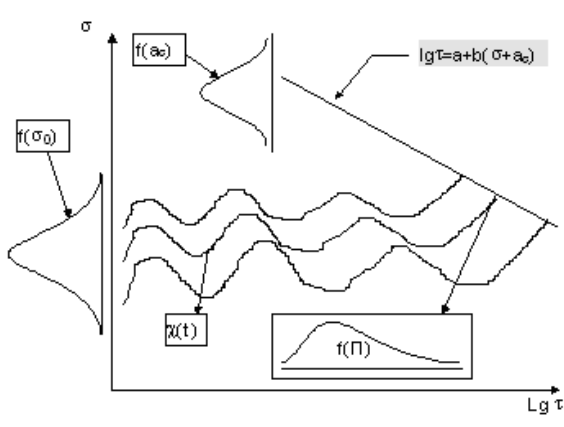
Fig. 5. The damage progress model under random stress The influence on the component in flight stress rates during the entire flight will differ by the constant value from the average values for these modes For example, this may be due to changing weather conditions, envi- ronment and other external factors of the